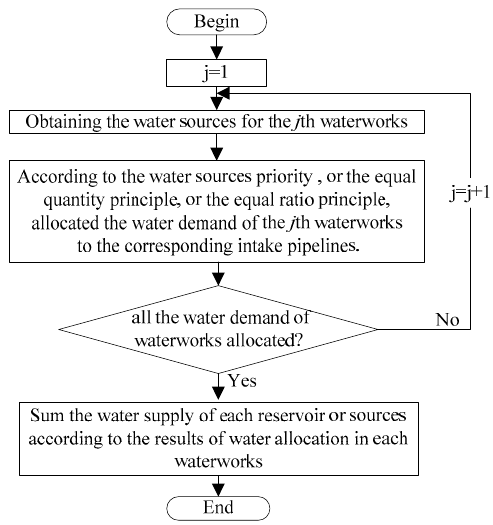
Figure 4. The flowchart of water allocation of the waterworks.